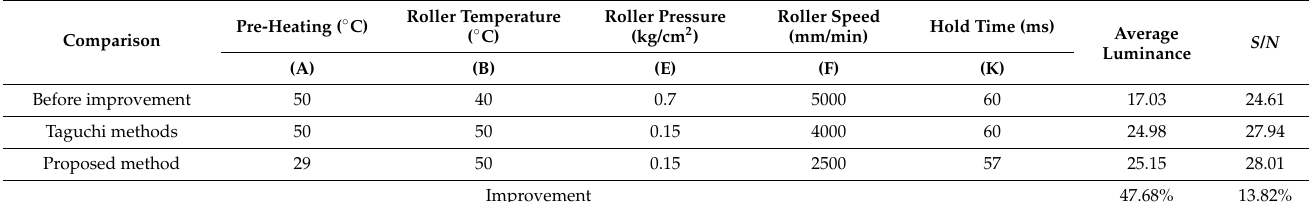
Table 19. The luminance of the original data, the Taguchi method, and the